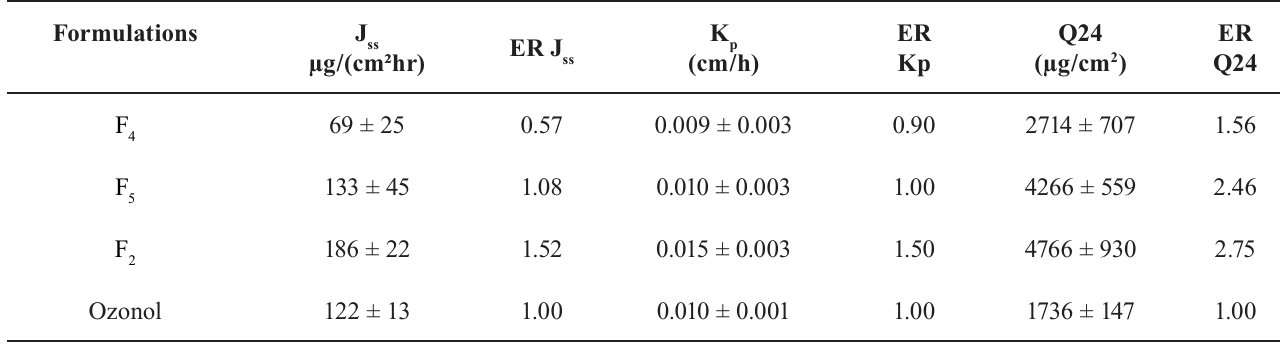
TABLE VI - In vitro permeation parameters for patches containing adhesive and Ozonol. The results are expressed as mean ± SEM